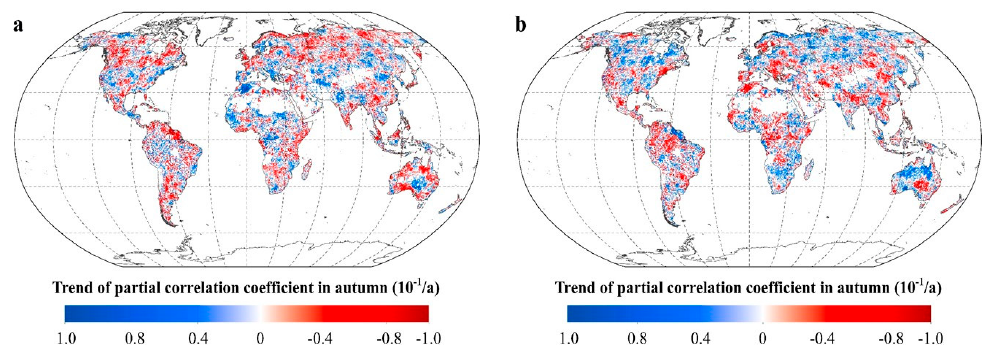
Figure 9. The response of vegetation greenness to the diurnal temperature in autumn. ( a . spatial distribution of the temporal trend of the partial coefficients between autumn NDVI and T max . b . spatial distribution of the temporal trend of the partial coefficients between autumn NDVI and T min . Supplementary Table S4).